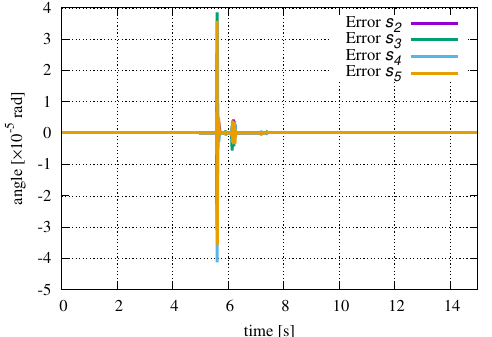
Figure 8. Case 1: Time variation of estimation error of the twist angle of the